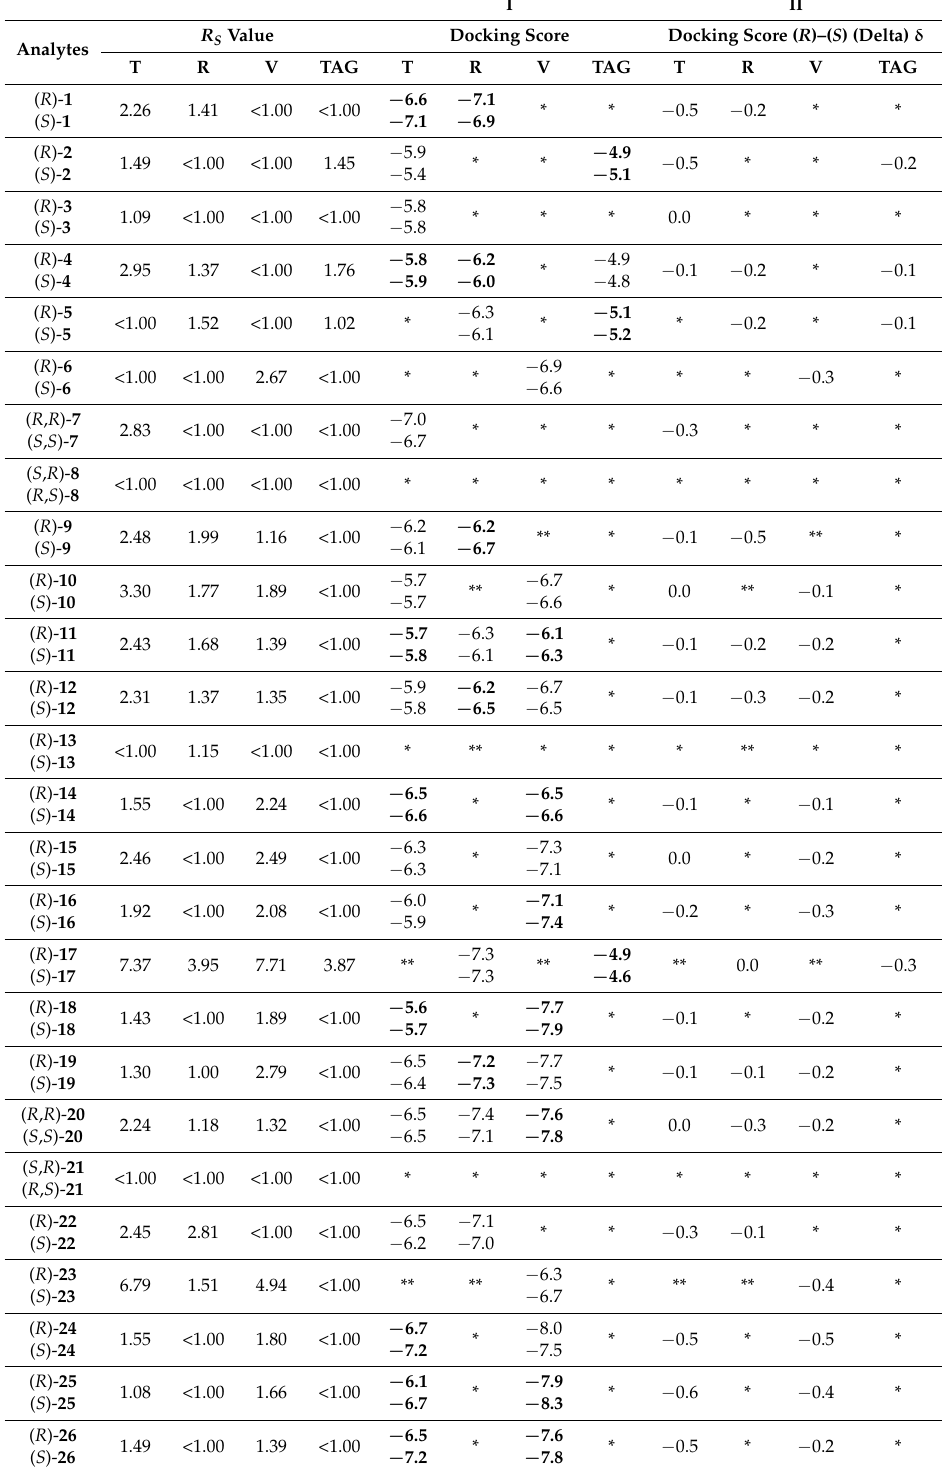
Table 5. Docking scores (Kcal.mol − 1 ) of both enantiomers of xanthonic analytes on Chirobiotic TM T, R, V, TAG ( I ), and binding affinity difference between ( R ) and ( S ) enantiomers ( II ). I II R S Value Docking Analytes